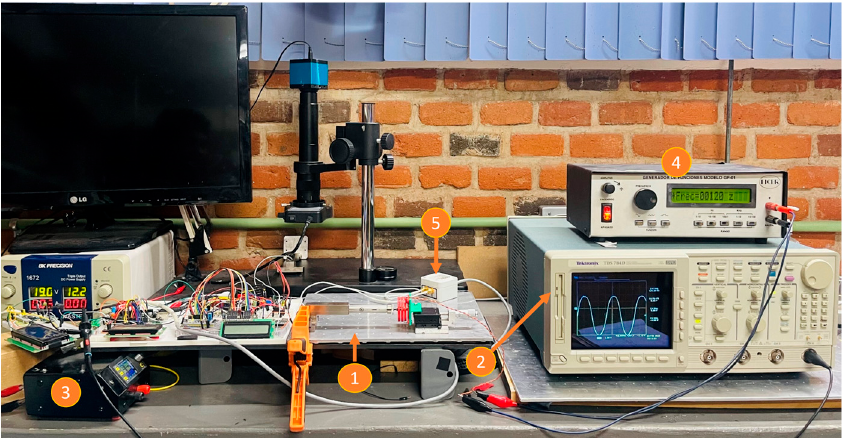
Figure 10. Experimental setup to determine the resonance frequency of the piezoelectric actuator. 1. Experimental setup (shown in Figure 8). 2. Oscilloscope Tektronix TDS 784D. 3. Power supply. 4. Frequency generator. 5. Control module.